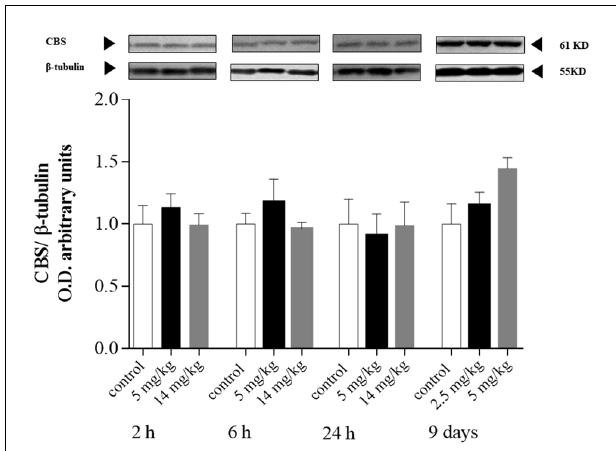
FIGURE 4 | Protein levels of cystathionine- β -synthase (CBS) in the cortex of mice treated with 0, 2.5, 5, or 14 mg/kg NaAsO 2 . Changes in the protein levels of total lysate homogenates were evaluated by Western blot analysis at 2, 6 h or 24, 24 h after the last NaAsO 2 administration. Bars show the densitometric analysis of the protein bands normalized to β -tubulin, mean ± SE, n = 6. The data were analyzed using one-way ANOVA with Tukey’s post hoc analysis.